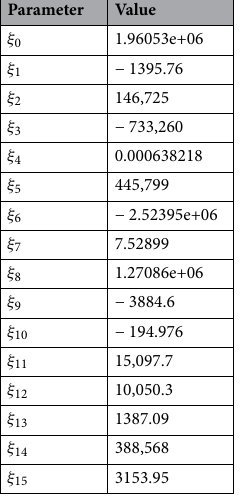
Table 7. The coefficients of proposed correlation by COMBI